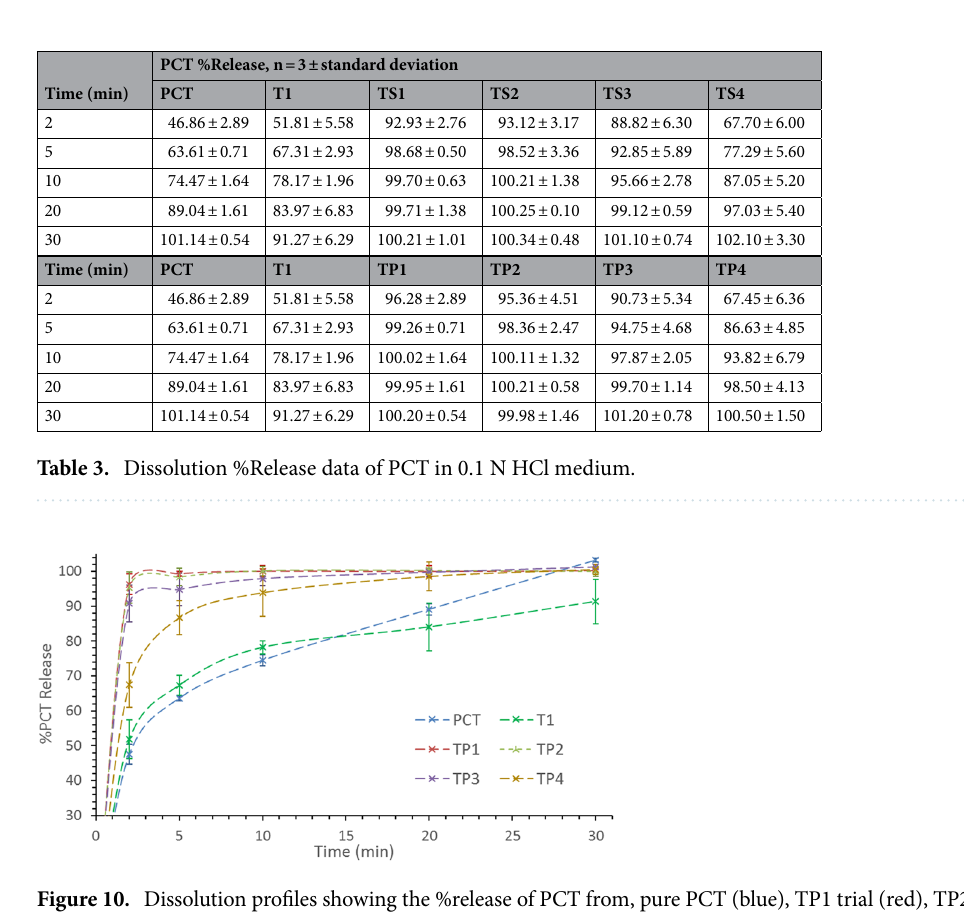
Figure 10. Dissolution profiles showing the %release of PCT from, pure PCT (blue), TP1 trial (red), TP2 (green), TP3 (purple), and TP4